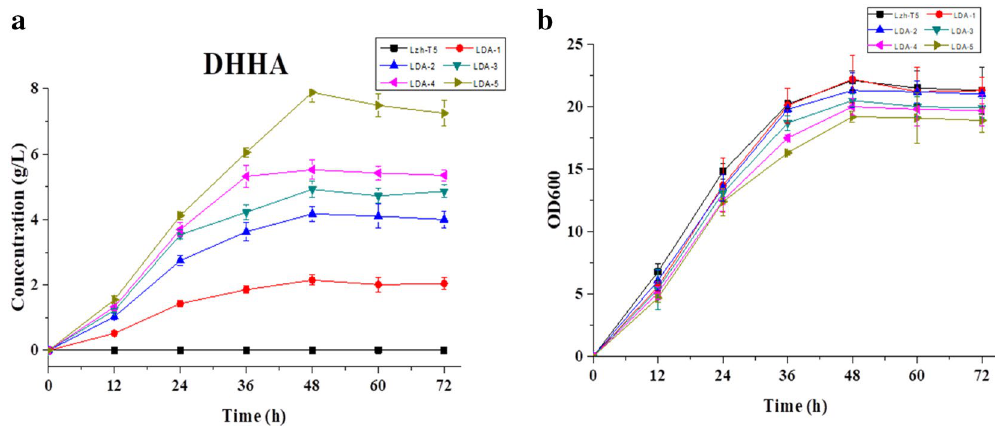
Figure 5. The DHHA production, growth curves of P. chlororaphis Lzh-T5, LDA-1, LDA-2, LDA-3, LDA-4, and LDA-5. ( a ) The DHHA production. ( b ) Growth curves.